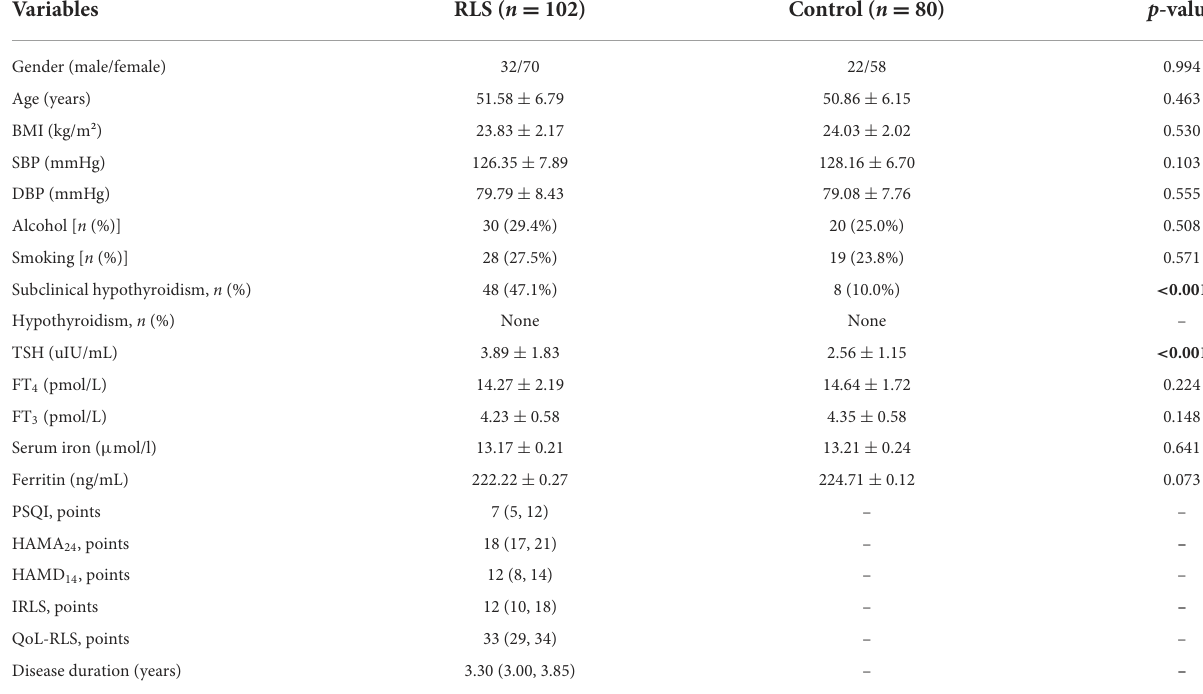
TABLE 1 Demographic features of control and RLS groups.